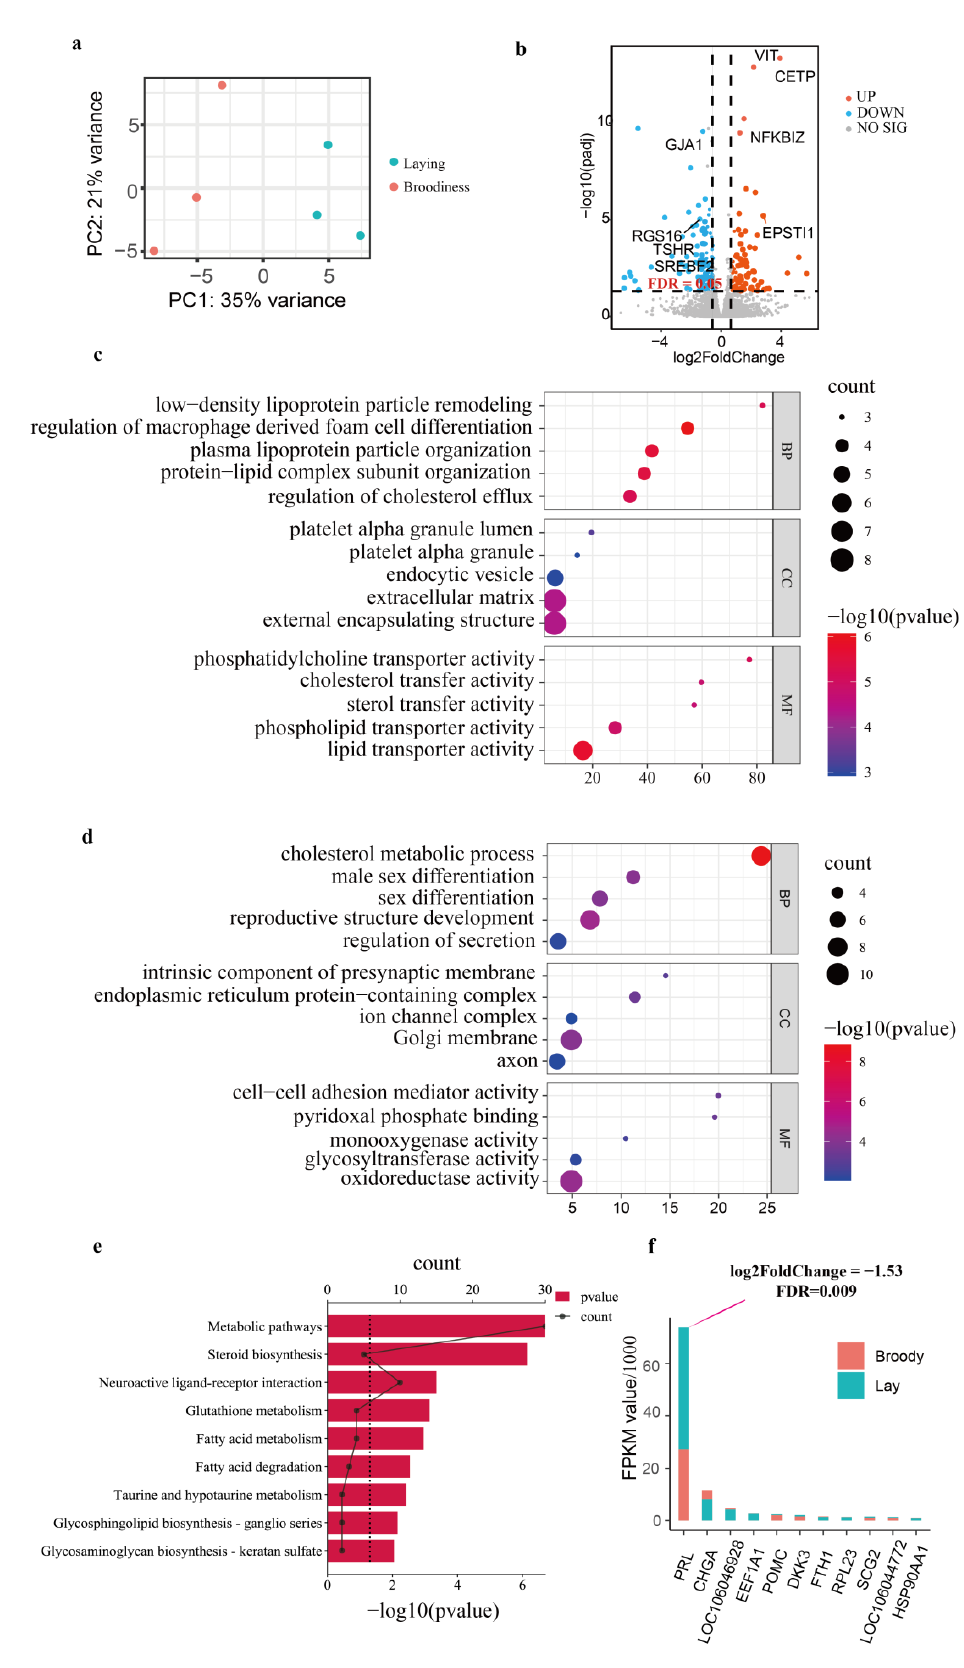
Figure 4. Transcriptome analysis of the differentially expressed genes (DEGs) in the goose pituitary underlying two reproductive stages. ( a ) The principal component analysis of different libraries